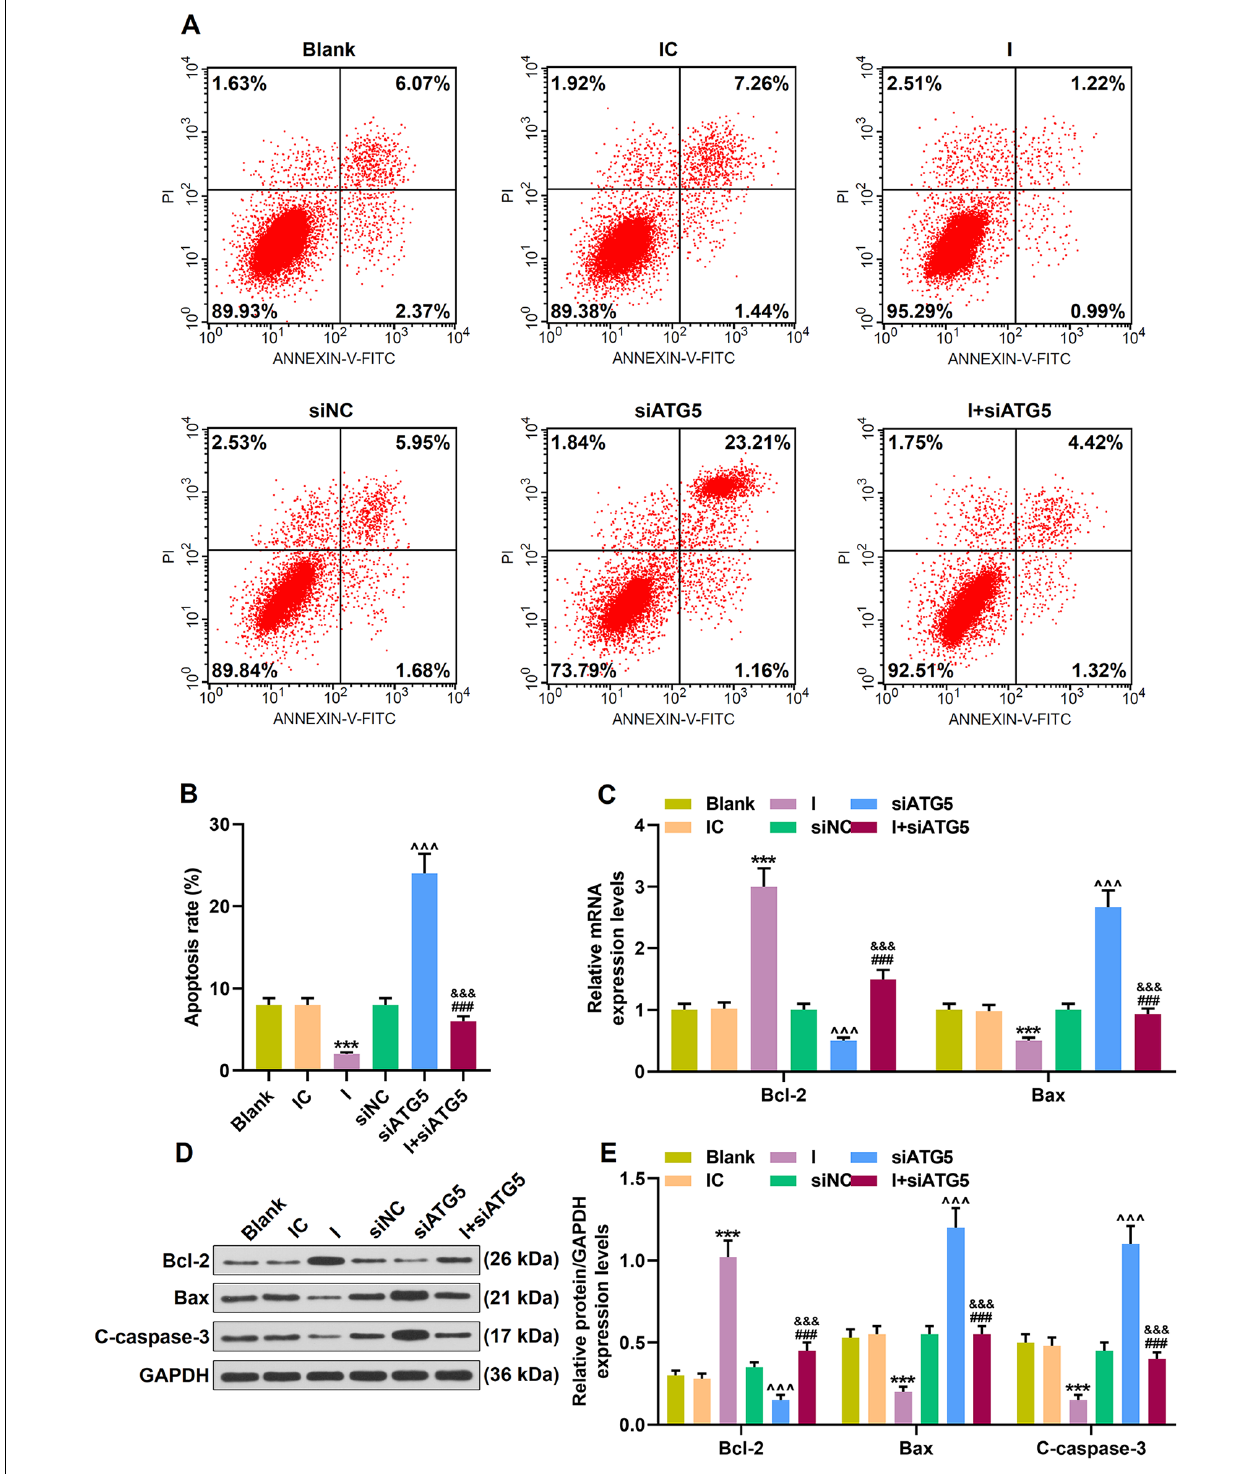
FIGURE 7 | Effect of MiR-30c-5p inhibitor on cell apoptosis and the expressions of apoptosis-related proteins in MPP+ stimulated SH-SY5Y cells via ATG5. (A) Flow cytometry analysis of the apoptosis rate of cells. (B) The apoptosis rate was calculated. (C) Expressions of Bcl-2 and Bax were determined by qPCR. (D,E) Expressions of Bcl-2, Bax and, cleaved caspase-3 (C-caspase-3) in SH-SY5Y cells were assessed by Western blot. GAPDH served as an internal control. ∗∗∗ p < 0.001 vs. IC. ∧∧∧ p < 0.001 vs. NC. &&& p < 0.001 vs. I. ### p < 0.001 vs. siATG5. NC, negative control for siRNA.